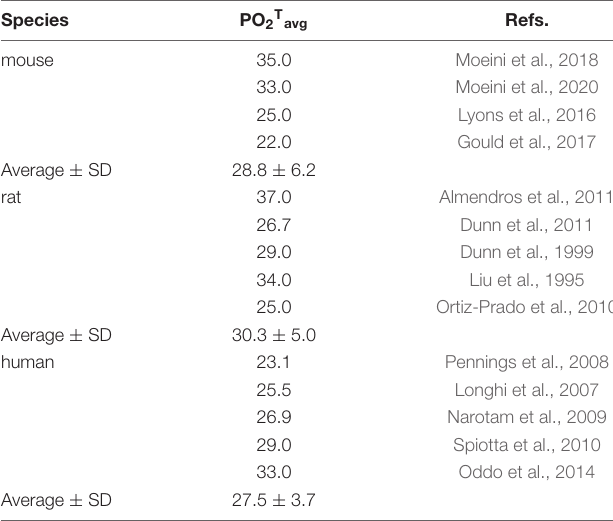
TABLE 1 | Similarity of PO 2T avg across species.